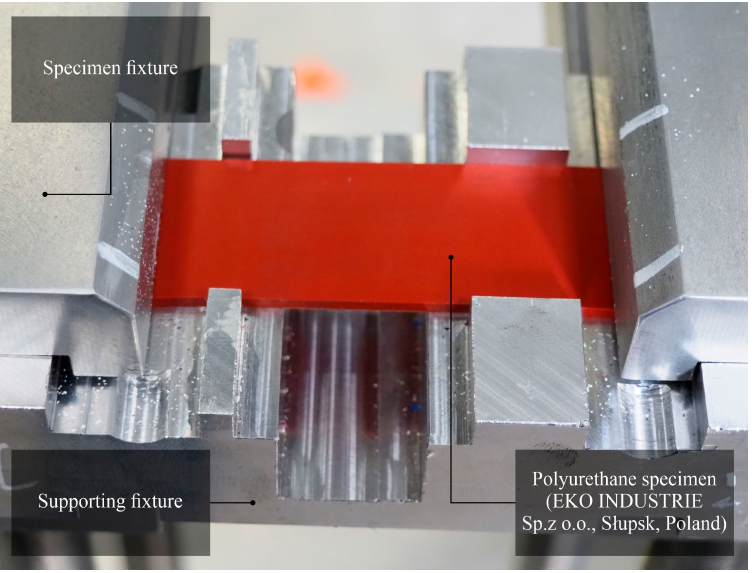
Figure 2. The method of fixing the sample on the measuring stand.